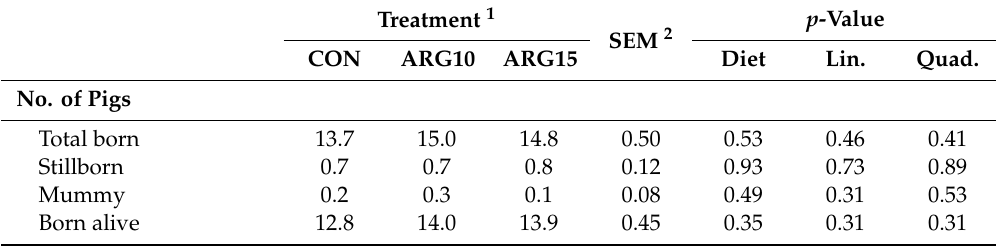
Table 3. E ff ects of arginine supplementation levels on reproductive performance in late-gestating